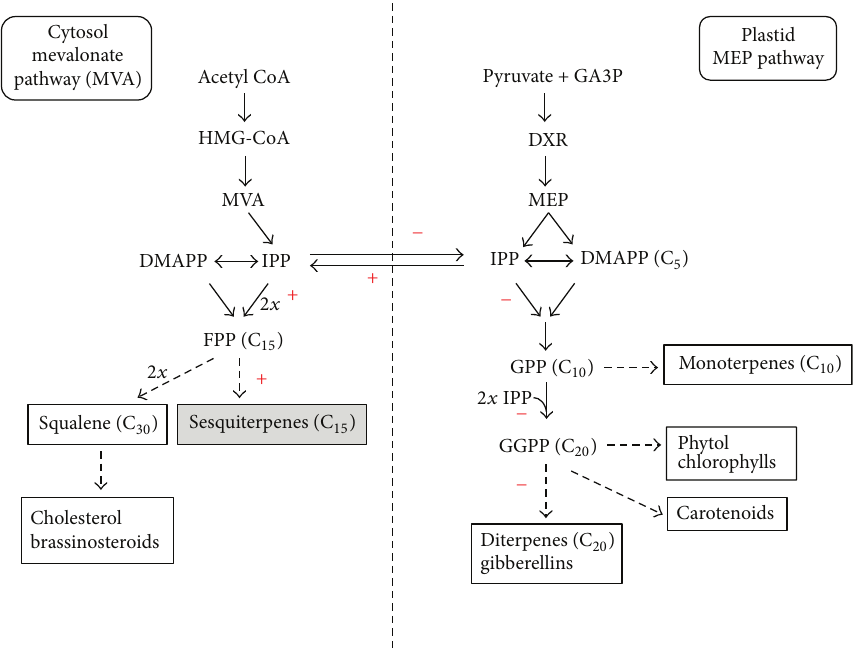
Figure 8: A simplified version of the sesquiterpene biosynthetic pathway. This pathway shows the predicted flux of substrate (IPP and FPP) to produce more sesquiterpenes (C 15 ) in transgenic plants overexpressing the PmSTS gene. (+) indicates the increased flux of substrate and ( − ) indicates the decreased flux of substrate. GA3P: glyceraldehyde 3-phosphate. HMG-CoA: 3-hydroxy-3-methylglutaryl-CoA. DXR: 1-deoxy- D-xylulose 5-phosphate reductoisomerase. MVA: mevalonate acid. MEP: methyl erythritol phosphate. IPP: isopentyl pyrophosphate and its isomer DMAPP: dimethylallyl diphosphate. FPP: farnesyl diphosphate. GGPP: geranylgeranyl diphosphate (modified from Okada et al. [31] and Vickers et al. [32]).